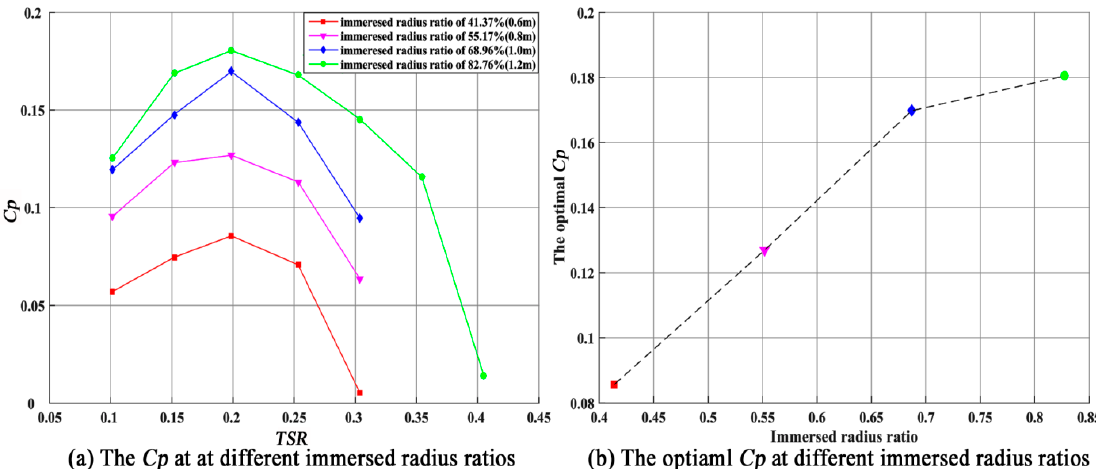
Figure 6. The C p and optimal C p among di ff erent immersed radius Figure 6. The (cid:1829) (cid:3017) and optimal (cid:1829) (cid:3043) among different immersed radius ratios.